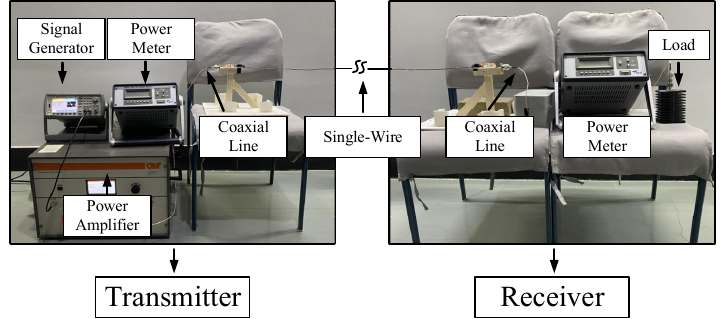
Figure 12. Experimental system of one-way single-wire power transfer.